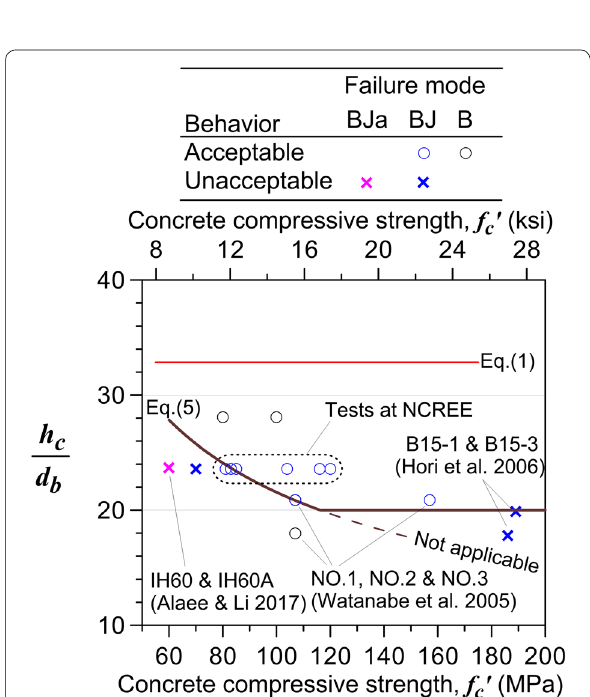
Fig. 8 Relations of the h c / d b ratio, measured concrete compressive strength, and evaluated hysteresis performance for joints with Grade 690 MPa beam bars.